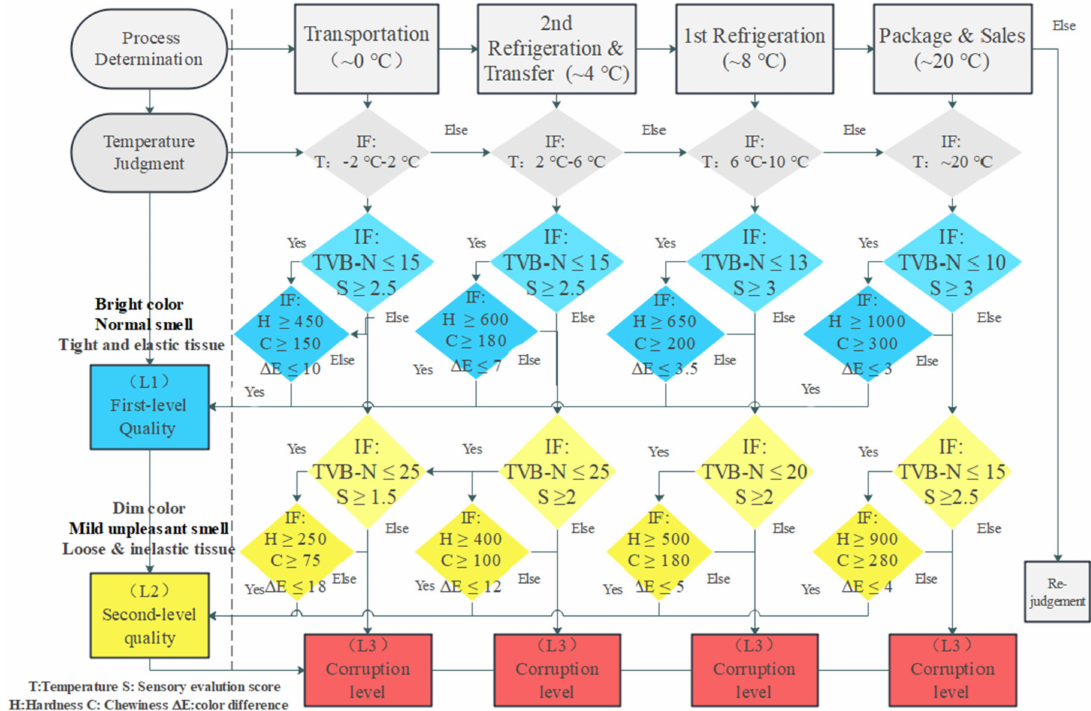
Figure 6. The quality evaluation standard based on knowledge rules under different